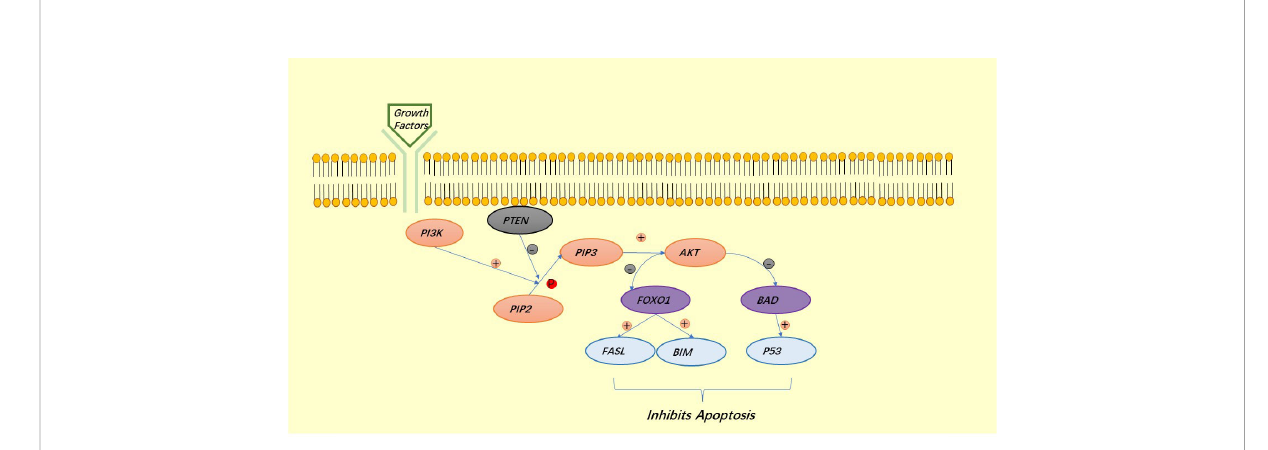
FIGURE 4 The PI3K signaling pathway involved in the regulation of